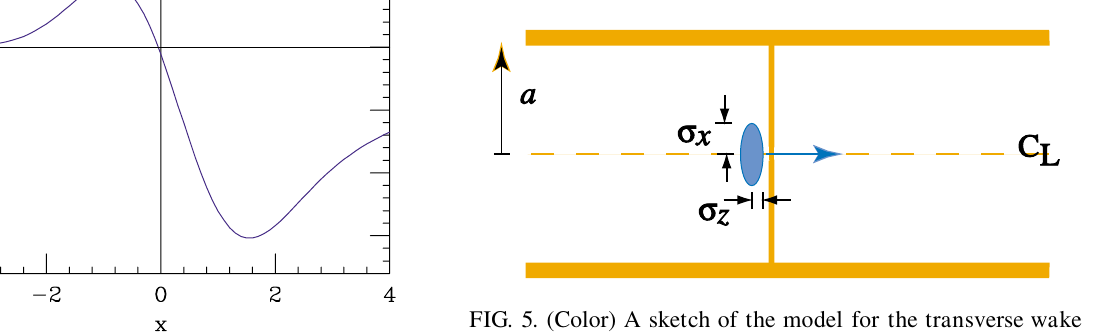
FIG. 3. (Color) The function f (cid:9) x (cid:10) defined by Eq. (27).